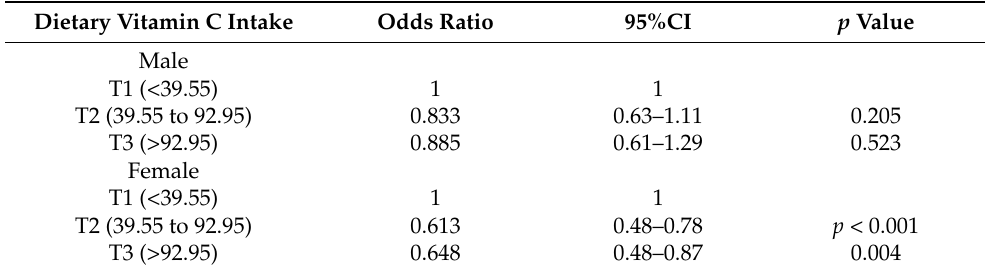
Table 3. Association between dietary vitamin C intake and depressive symptoms after sex stratification. Dietary Vitamin C Intake Odds Ratio 95%CI p Value